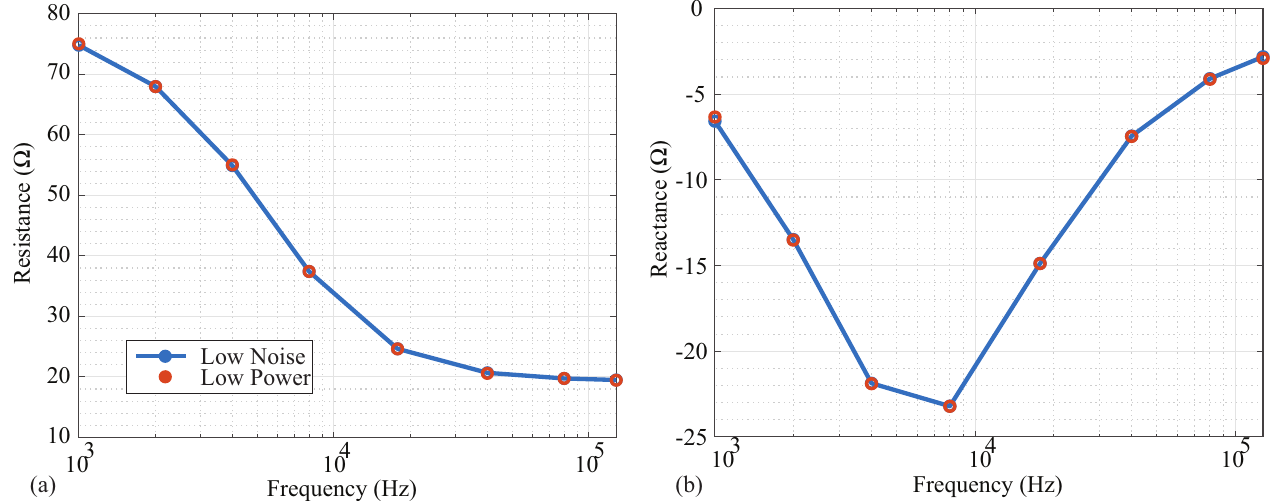
Figure 8. ( a ) Resistance and ( b ) reactance measurements of Model 1 by MAX3000x in low-noise (blue) and low-power (red) operating modes. Table 3. Standard deviation of resistance and reactance measurements of the 2 R − 1 C model by MAX3000x in low-power and low-noise operating